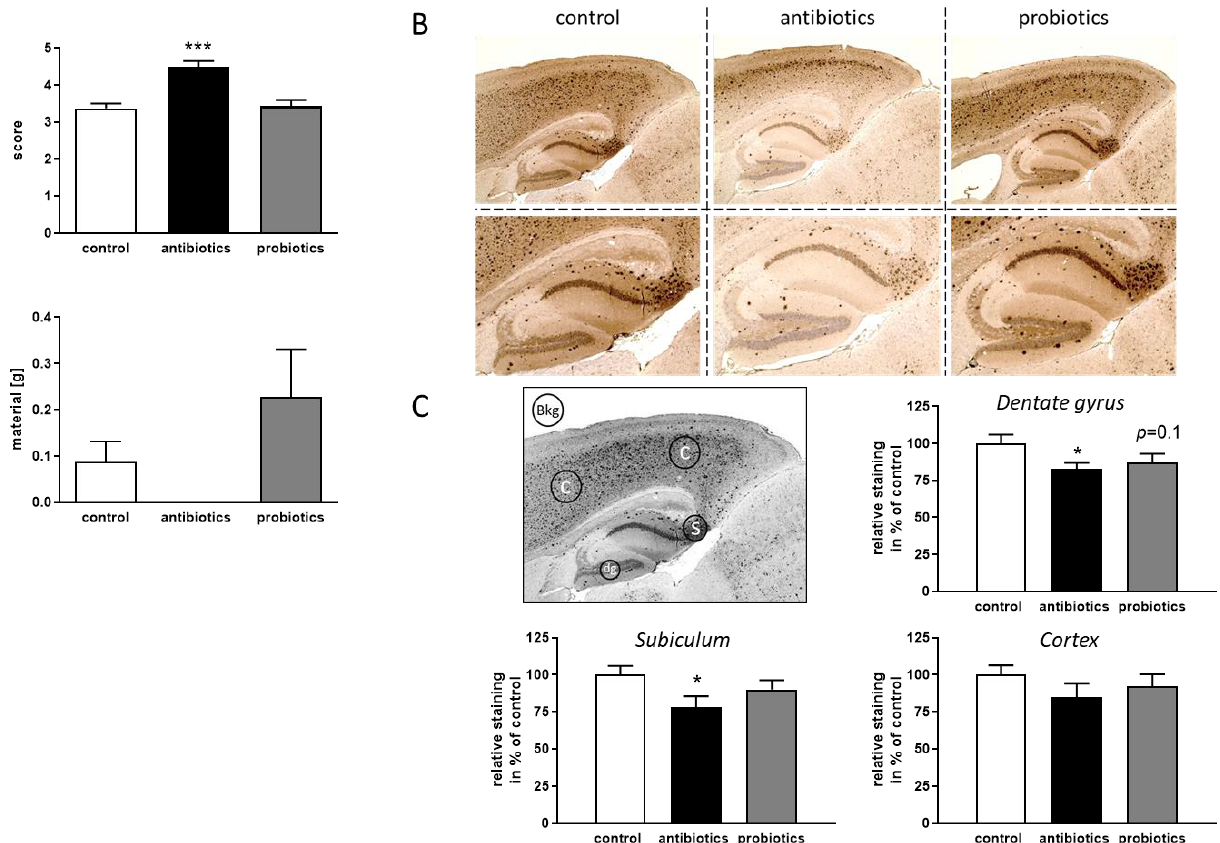
Figure 2. Influence of gut microbiota manipulation on pathological hallmarks of 5xFAD mice. ( A ) Within the 14th week of treatment, nest-building ability as a proxy for hippocampal function was assessed: quality of the nests (score) as well as the amount of not integrated material were measured. Statistics were performed with a one-way ANOVA and Tukey’s post-test (***, p < 0.001). ( B ) After 14 weeks of treatment, animals were sacrificed and sagittal sections of the brain were stained for A β -depositions. The area of the hippocampus is shown magnified within the exemplary pictures. ( C ) A β - depositions were quantified densitometrically in the indicated brain regions of two independent slices per animal and corrected for background staining intensity (Bkg.). Pixel measures were normalized to the mean of control-treated animals and are depicted as percentage. Data are presented as mean + SEM. (Multiple t-test; *, p < 0.05; one sample from the antibiotics-treated animals was not analyzed due to technical